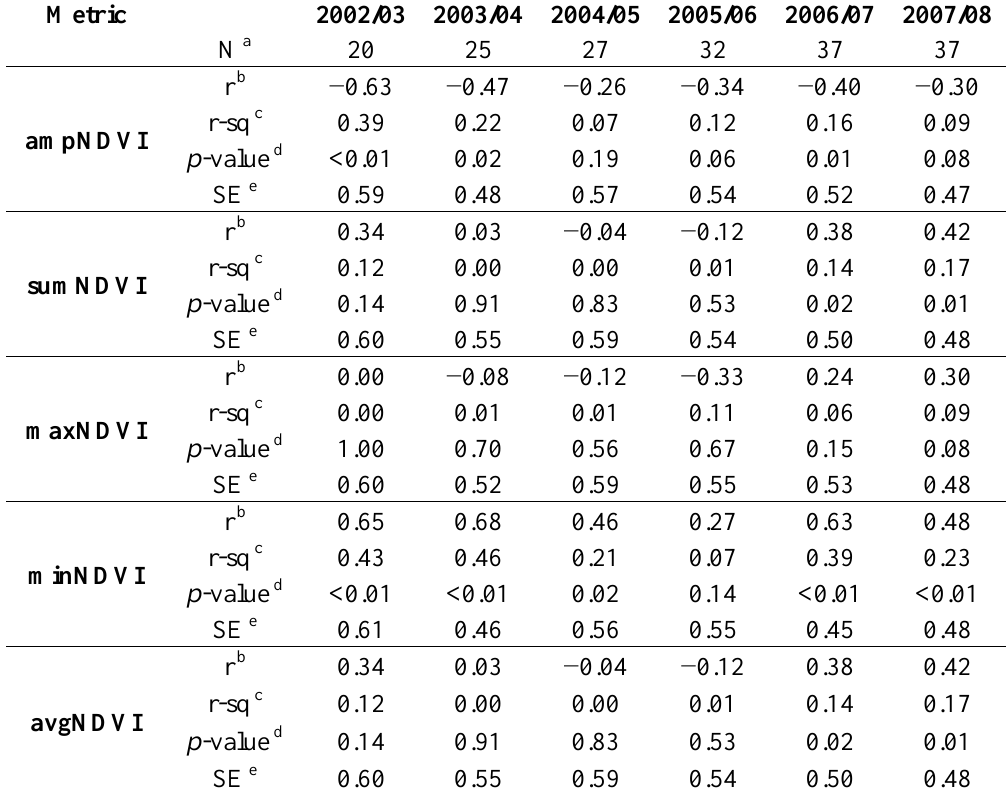
Table 5. Correlation coefficients between variation on NDVI metrics and variation on coffee yield the following year for each metric